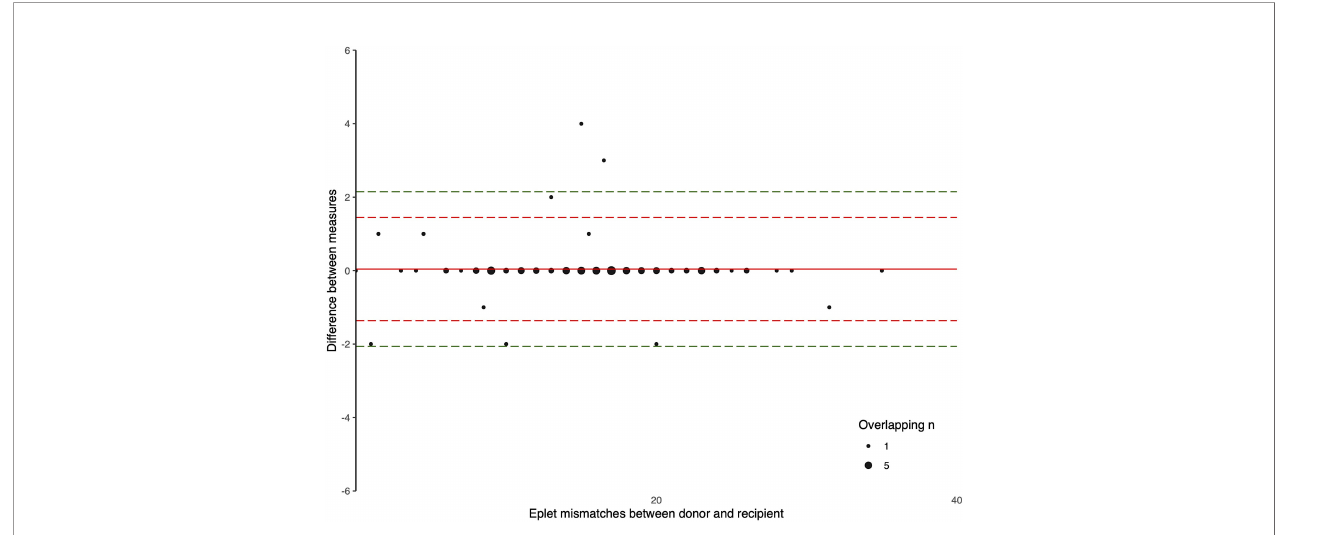
FIGURE 1 | Bland Altman Plot – total HLA class I eplet mismatches. A positive result indicates a greater number of eplet mismatches identi fi ed by NGS-typing compared to LD-typing. The red and green dashed lines represent 2 and 3 standard deviations from mean